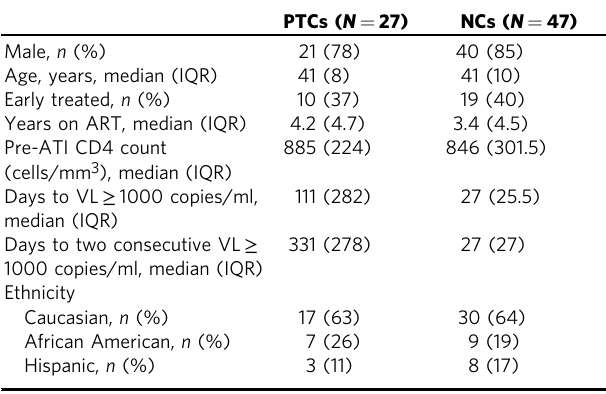
Table 1 Demographic and clinical characteristics of PTCs and NCs from the ACTG